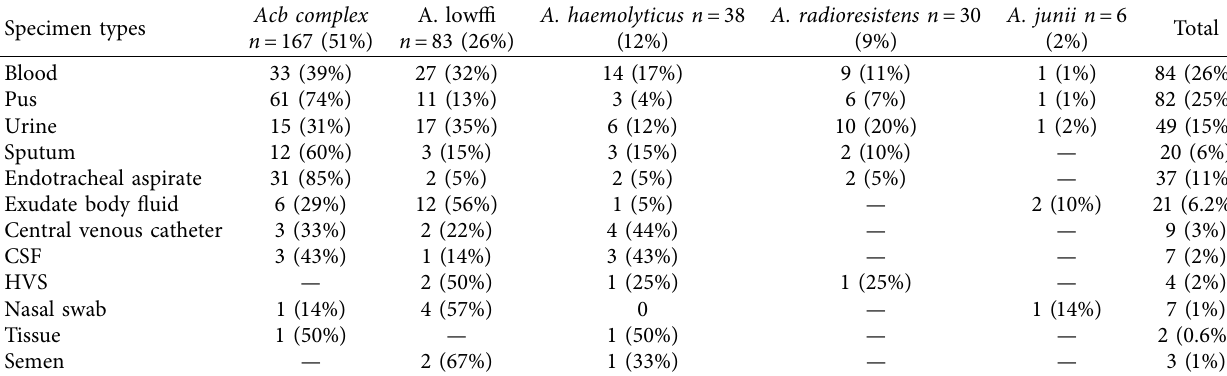
Table 1: Acinetobacter species from diferent clinical samples ( n � 324).